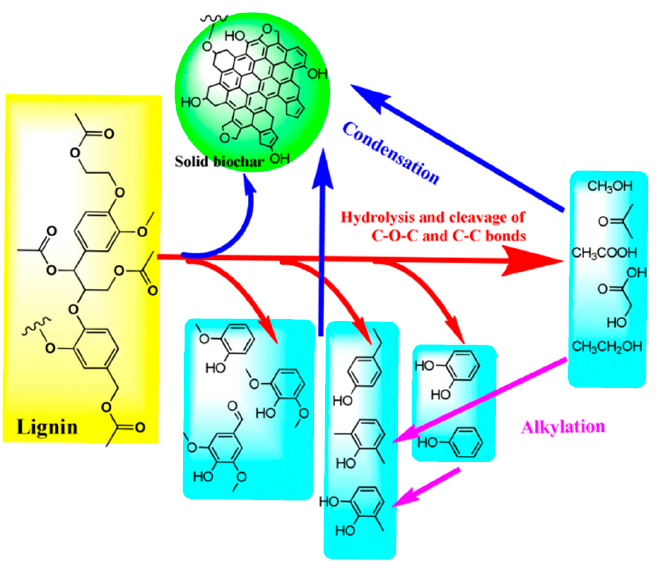
Figure 4. The mechanism of lignin HTC. Reprinted with permission from Ref. [29]. Copyright 2015 Royal Society of Chemistry.